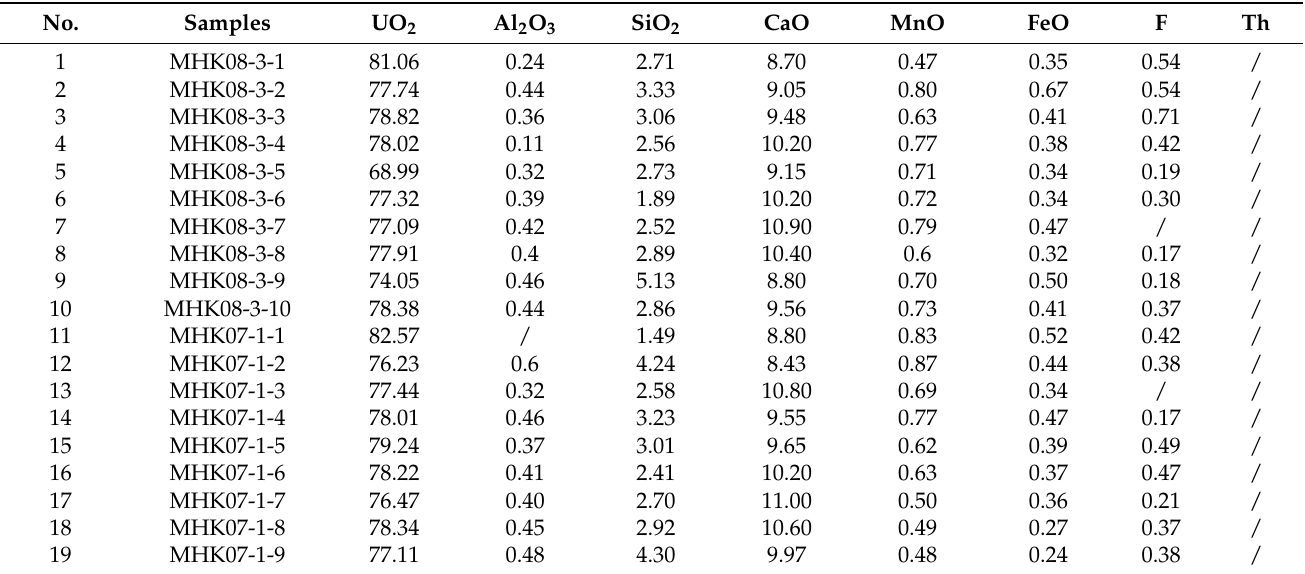
Table 4. Representative EMPA analyses (wt%) of pitchblende. “/” means “below detection